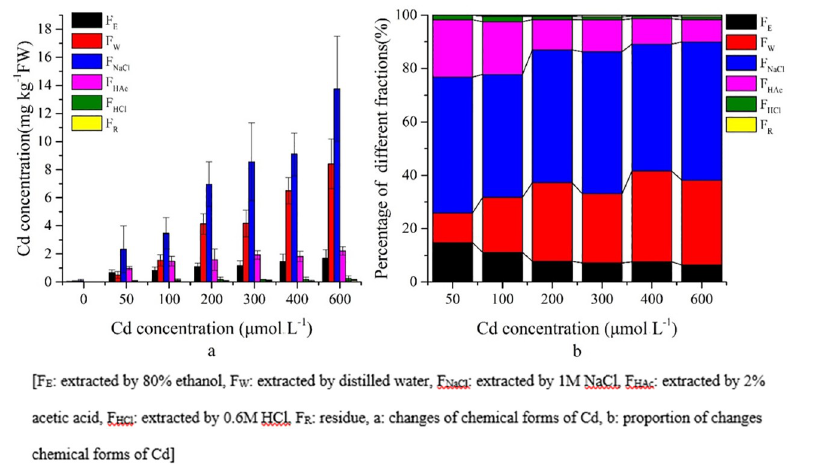
Fig 7. Chemical forms of Cd and proportions in S . portulacastrum